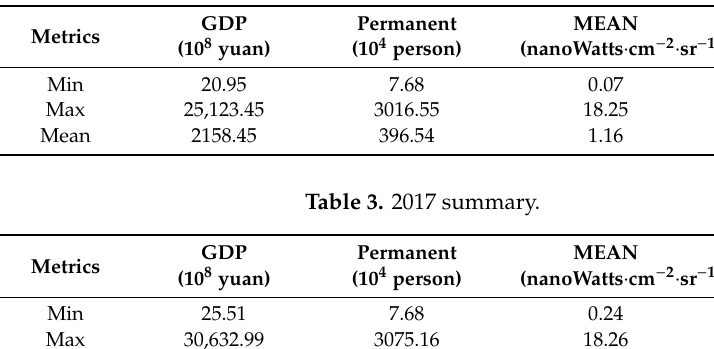
Table 2. 2015 summary.